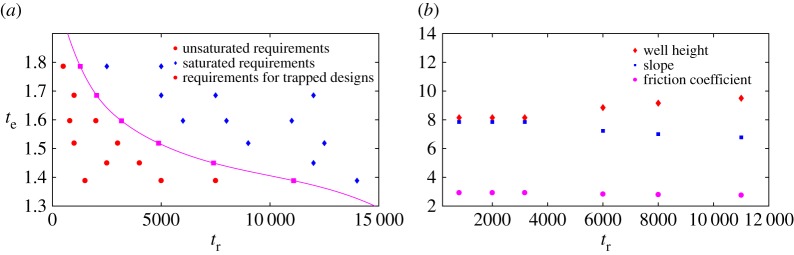
Illustration of the division of requirement space (RS) into saturated and unsaturated regions by requirements that correspond to trapped designs. (a) Squares show requirements (te,tr) that are saturated by trapped designs for the family of protocols we consider. Numerical optimization shows that requirements to the left of the locus defined by these points are unsaturated (circles), whereas requirements to the right are saturated (diamonds). (b) A plot of the optimal designs for points from (a) at te=1.5967. It is clear that for requirements tr≤3173, lying to the left of the trapped-design locus in (a), optimal design parameters are identical, whereas they are distinct for tr>3173.